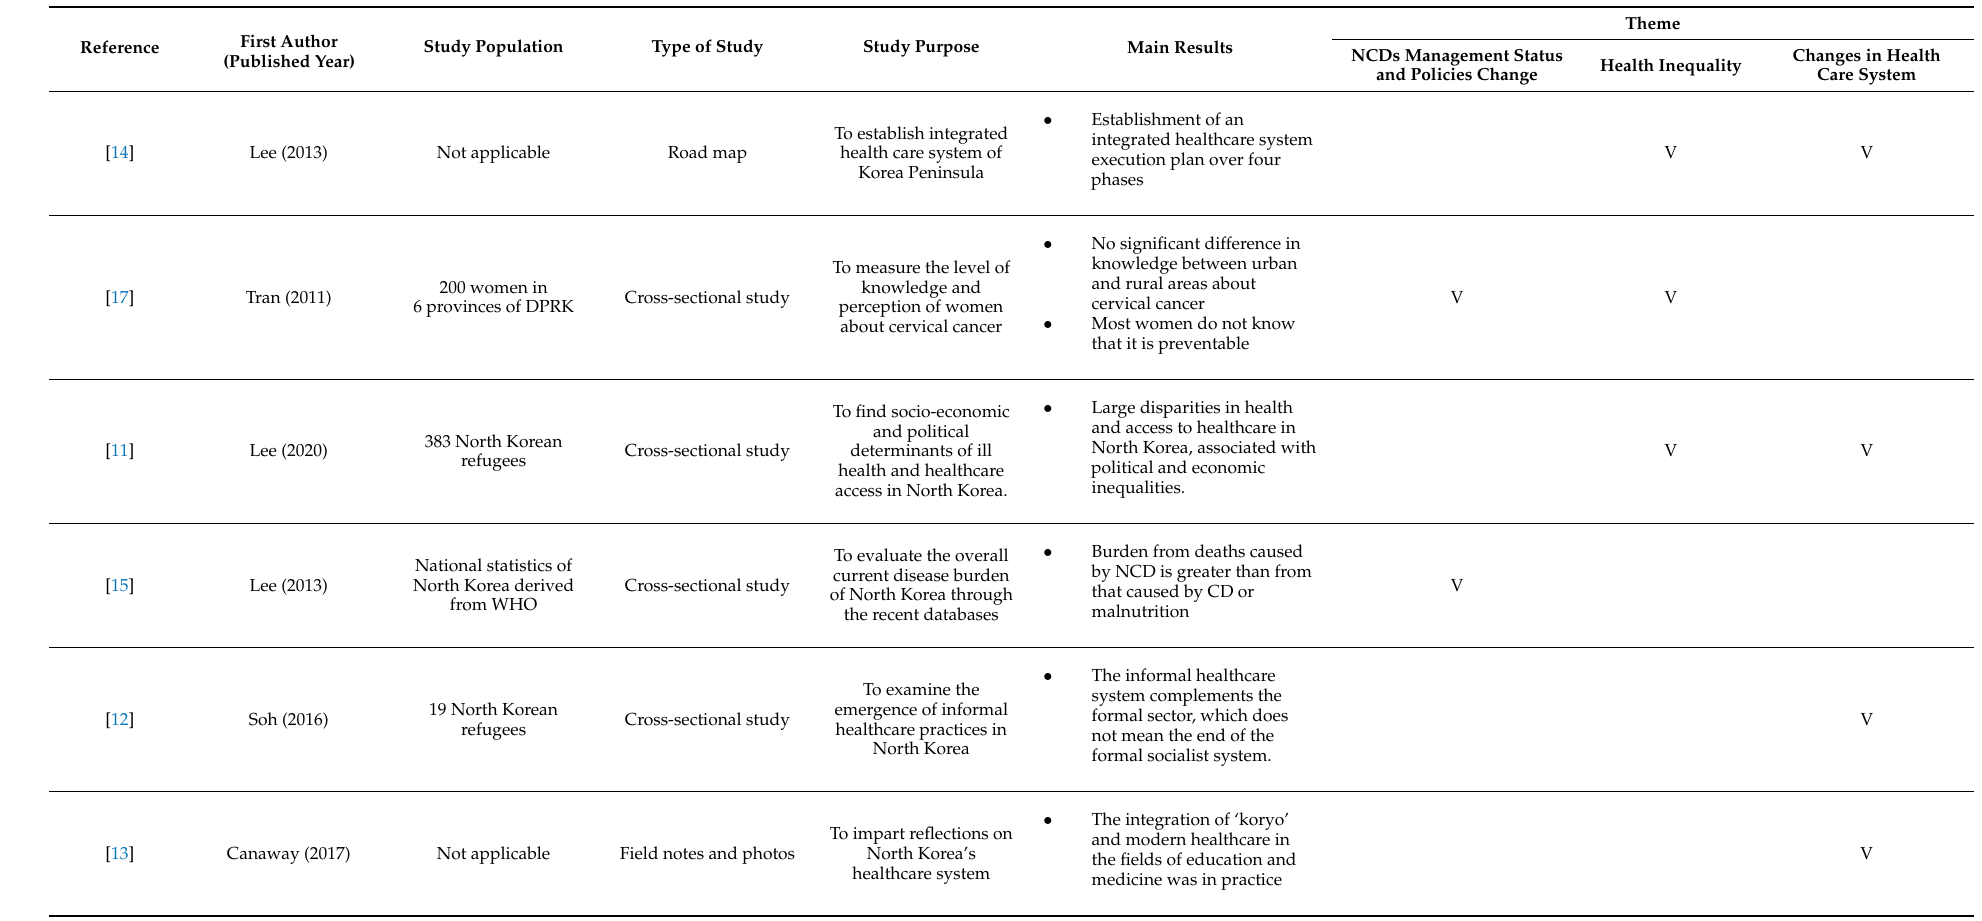
Table 1. Brief Summary of Reviewed